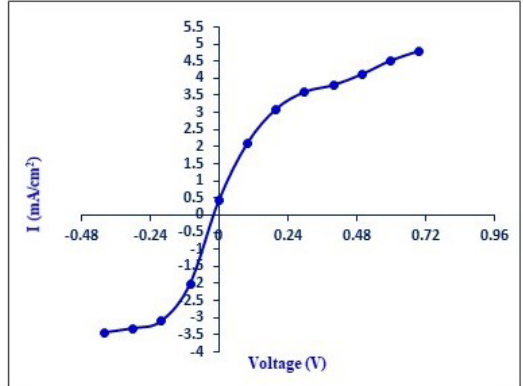
Zn Se photoelectrode (in dark). 0.5 0.5